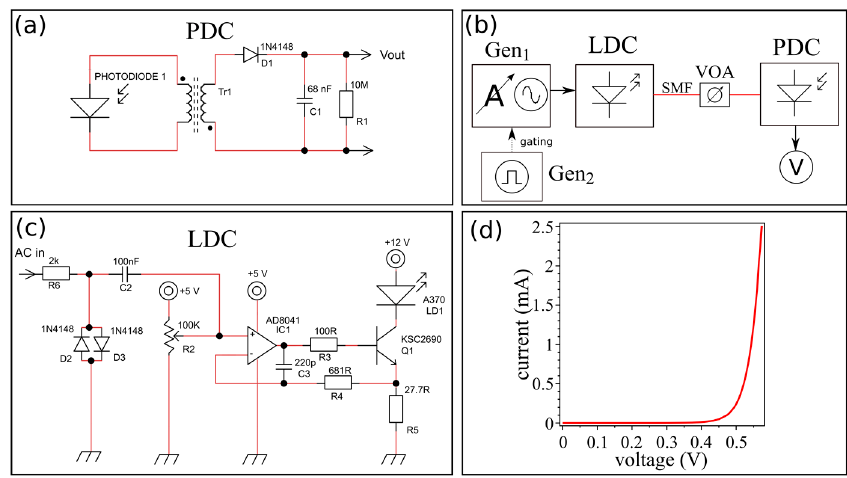
Figure 5. ( a ) Photodiode circuit (PDC) used in the experiment, ( b ) experimental setup for study of PDC operation, ( c ) laser drive circuit (LDC) used in the experiment, ( d ) I-V curve of photodiode employed in PDC.